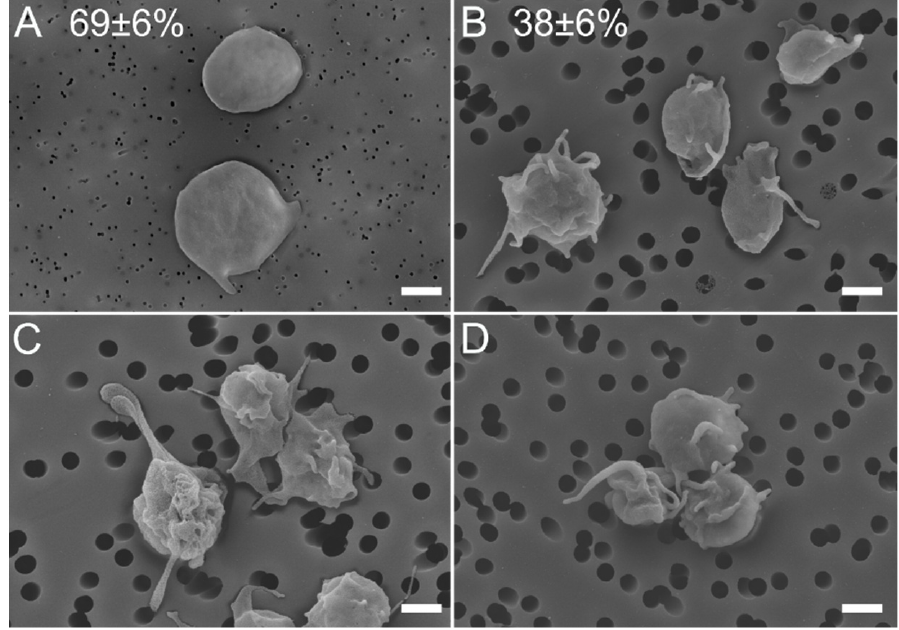
Figure 2. Representative scanning electron micrographs show a background activation of circulating platelets in the blood of SLE patients. ( A ) Characteristic morphology of unstimulated resting platelets isolated from the blood of a healthy subject (control). ( B – D ) Unstimulated platelets isolated from the blood of SLE patients with morphological signs of activation: loss of discoid shape, formation of filopodia and other membrane protrusions, and aggregation. Scale bars = 1 µ m. Numbers represent the percent of platelets with the morphological signs of resting/quiescent state in control ( A ) and SLE ( B ) samples. Platelets were settled on the polycarbonate filter with 0.1 µ m ( A ) or 0.4 µ m ( B – D ) pore size.